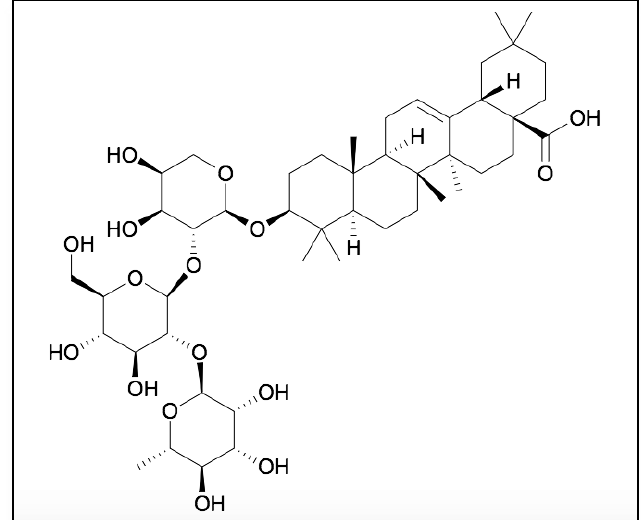
Figure 1. Molecular structure of RA.